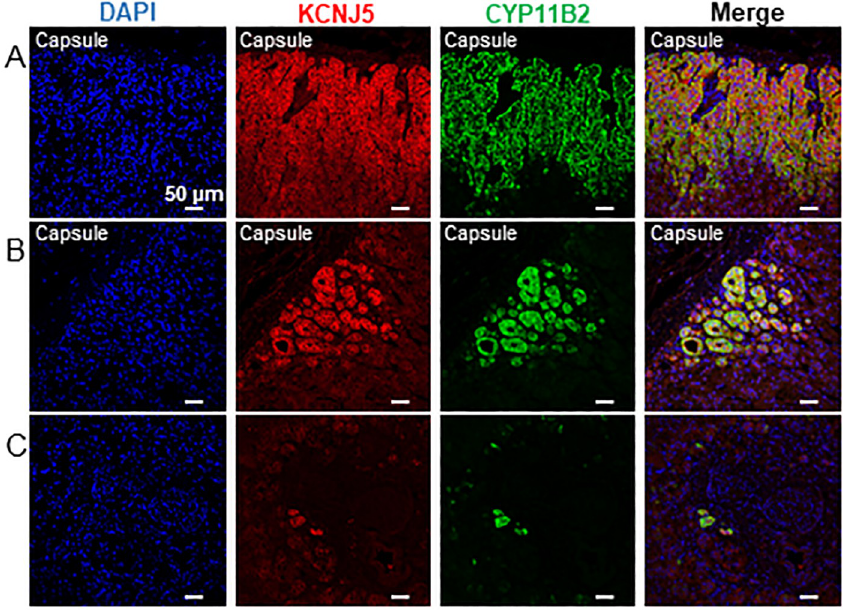
Fig 7. KCNJ5 expression in the normal human adrenal cortex. Double immunofluorescence of KCNJ5 and CYP11B2 reveals that KCNJ5 is highly expressed in aldosterone producing cells (A, B, C). Intense KCNJ5 immunolabelling is observed in CYP11B2 cells arranged in large (A) or small (B) APCC or isolated in the deep cortex (C). Cell nuclei were visualised with DAPI. (A) 42-year-old man. (B) 45-year-old man. (C) 52-year-old woman.